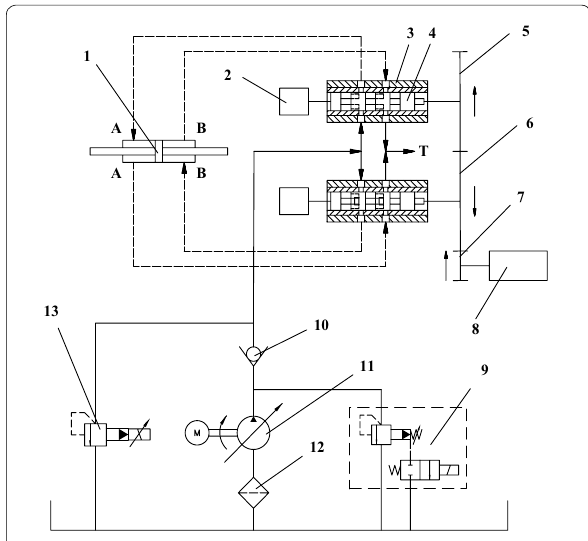
Figure 24 New method of twin-valve independently controlled high-frequency electro-hydraulic vibration. 1. Vibration hydraulic cylinder; 2. Linear motor; 3. Valve body; 4. Spool; 5. Large gear 1; 6. Large gear 2; 7. Small gear; 8. Servo motor; 9. Pilot electromagnetic relief valve; 10. One-way valve; 11. Constant pressure proportional variable pump; 12. Filter; 13. Pilot proportional relief valve